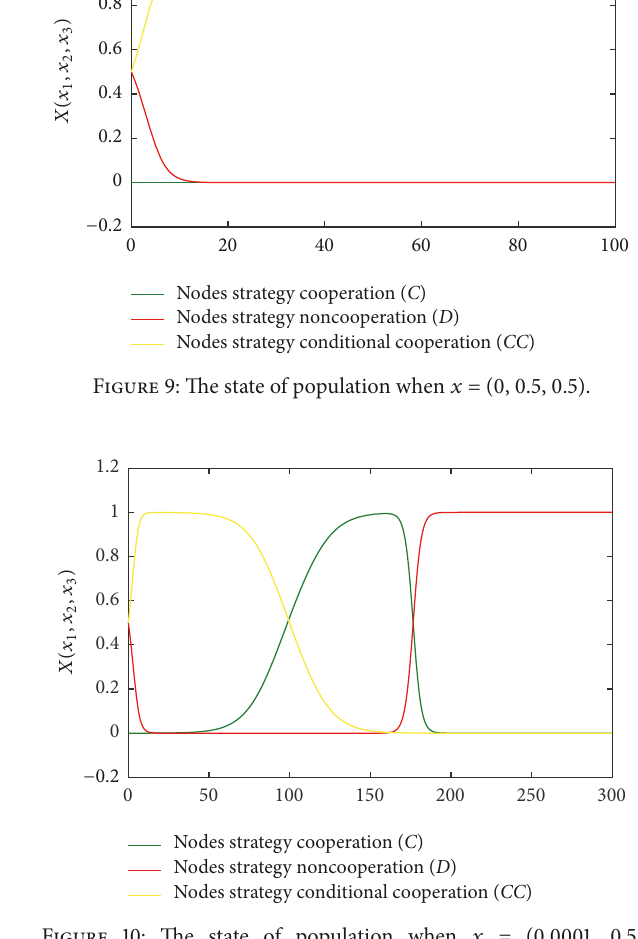
Figure 10: The state of population when 𝑥 = (0.0001, 0.5,